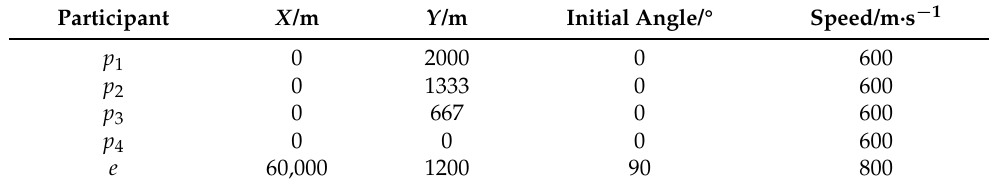
Table 1. Participants’ initial parameter settings.